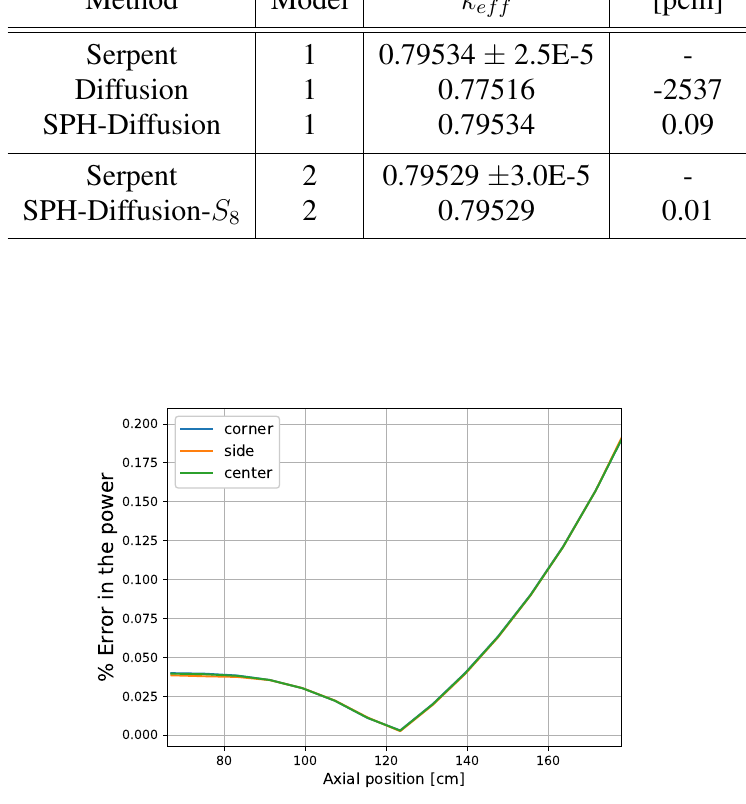
Figure 6: % Error in the axial power for each assembly type in CR model